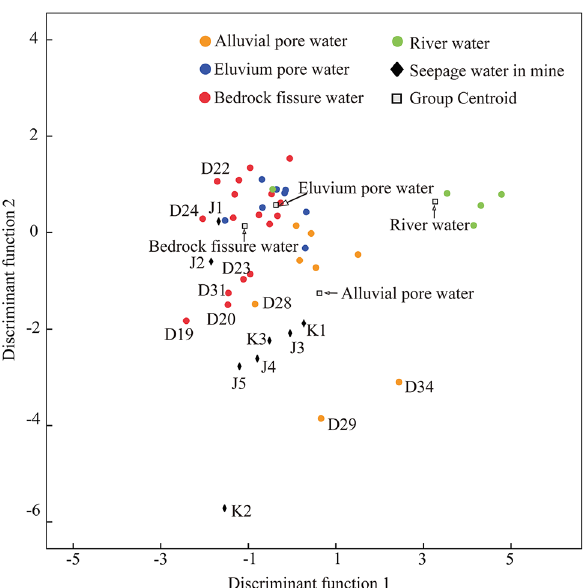
Figure 8. Scatter plot of each sample score with the first and second discriminant